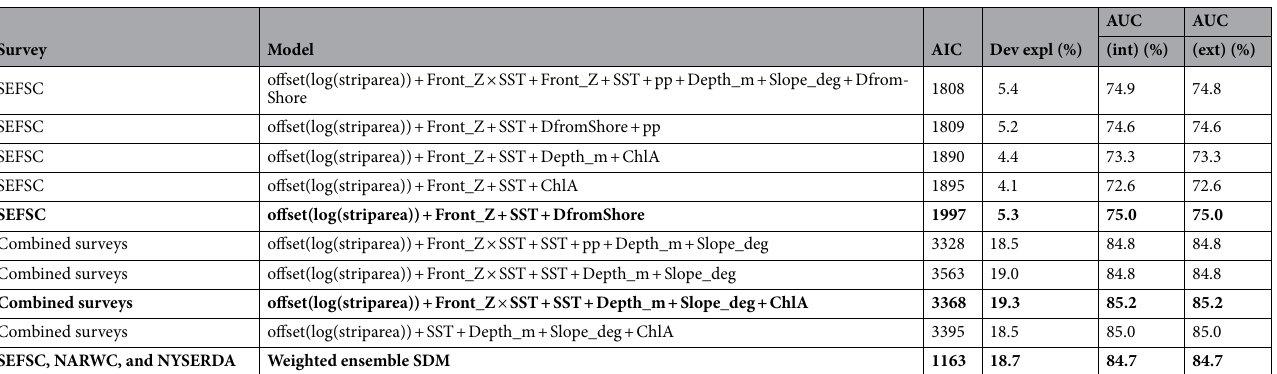
Table 2. Model fit summaries for different survey datasets with akaike information criterion (AIC), residual deviance explained (DevExpl), and area under the curve (AUC) from ten-fold internal (int) and external (ext) cross-validation from independent samples. Selected model in bold for each survey. ‘Combined Surveys’ denotes models fit to data from the SEFSC, NARWC, and NYSERDA